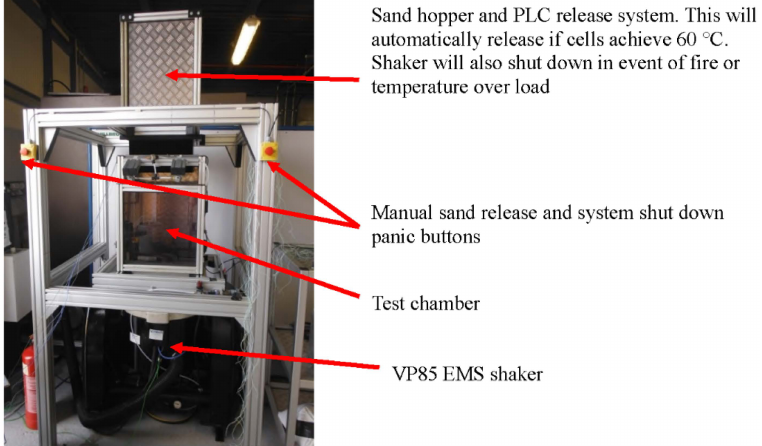
Figure 2. Test set